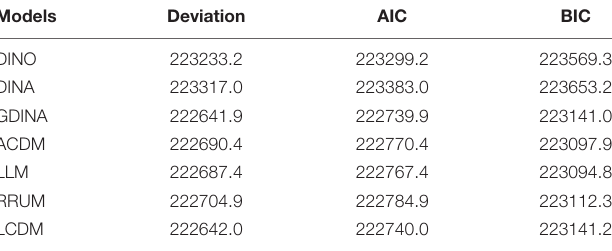
TABLE 4 | Parameter statistics comparison of different models. Models